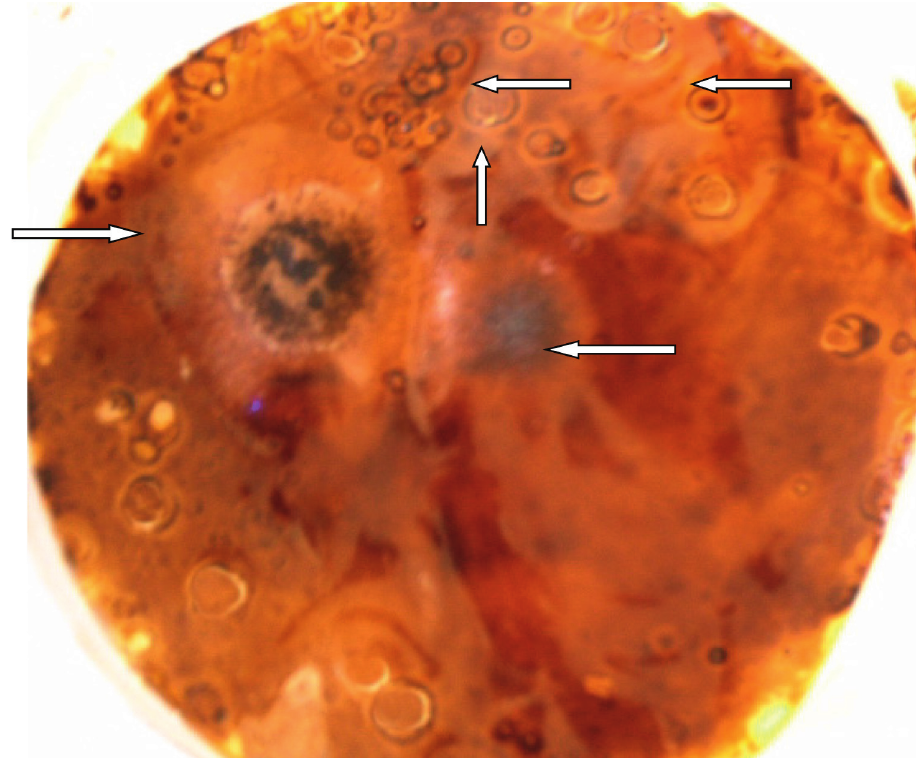
Figure 2: Microbial colonies that were screened on solidified Czapek’s Dox medium complemented with petroleum hydrocarbons as a solitary carbon source have shown a clear modification in the appearance of petroleum oil surrounding